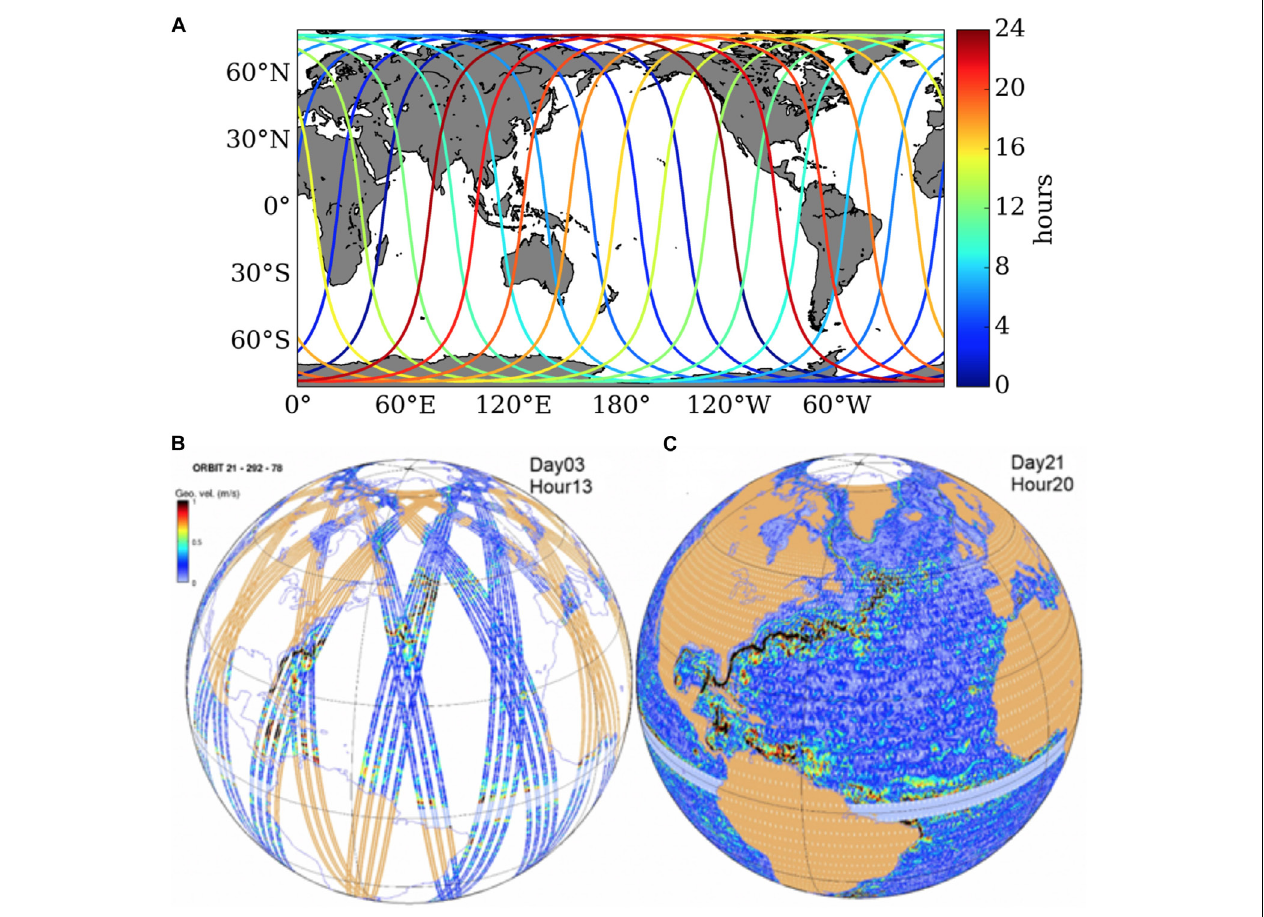
FIGURE 5 | (A) Global coverage of SWOT’s 1-day orbit. Color shows the time in hours of each pass (Wang et al., 2018) © Copyright [2018] American Meteorological Society (AMS). SWOT coverage in its 21-day orbit after 3 days (B) and 21 days (C) . The color shows model simulations of SSH at the measurement time (after Morrow et al., 2018a; copyright 2018 , CreateSpace Independent Publishing Platform